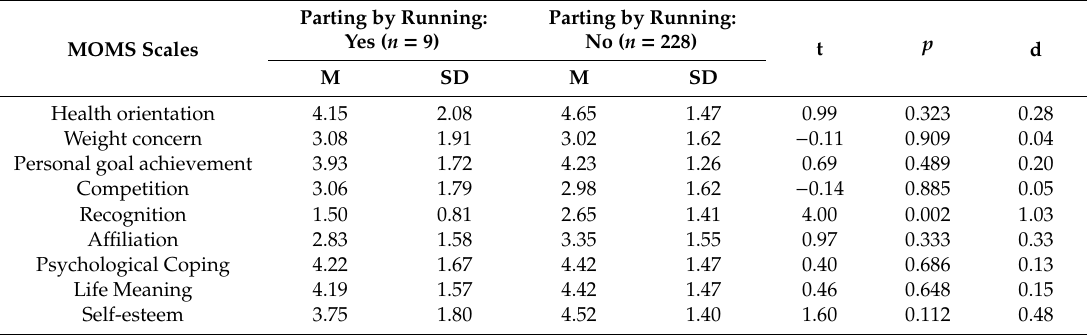
Table 8. Motives of runners who parted with partner because of running vs. runners who never parted because of